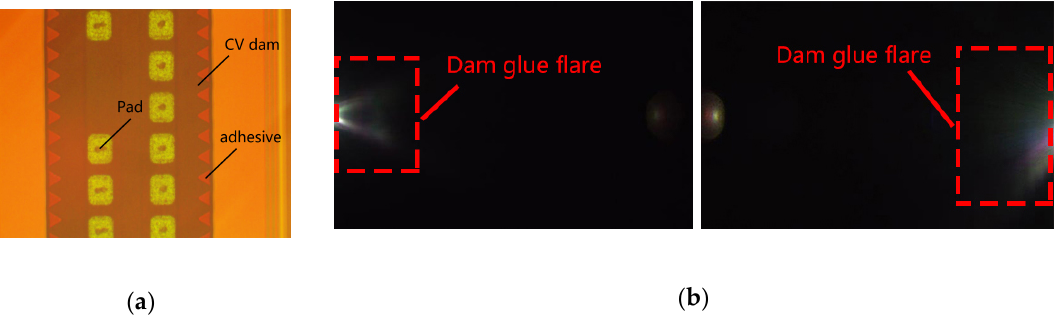
Figure 9. (a) Adhesive overflowed the CV dam; ( b ) flare image issue caused by dam glue reflection. Figure 9. ( a ) Adhesive overflowed the CV dam; ( b ) flare image issue caused by dam glue